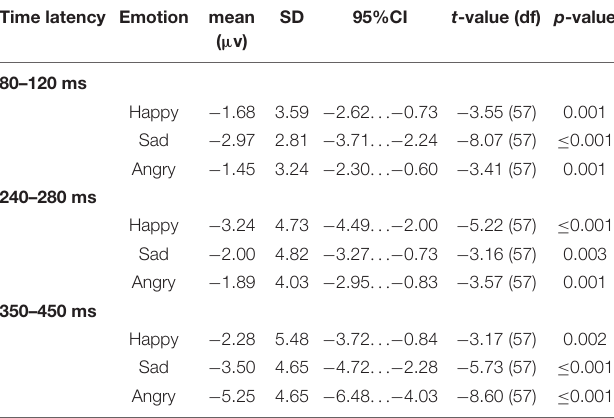
TABLE 1 | Results of the two-tailed one-sample t -tests ( n = 58).